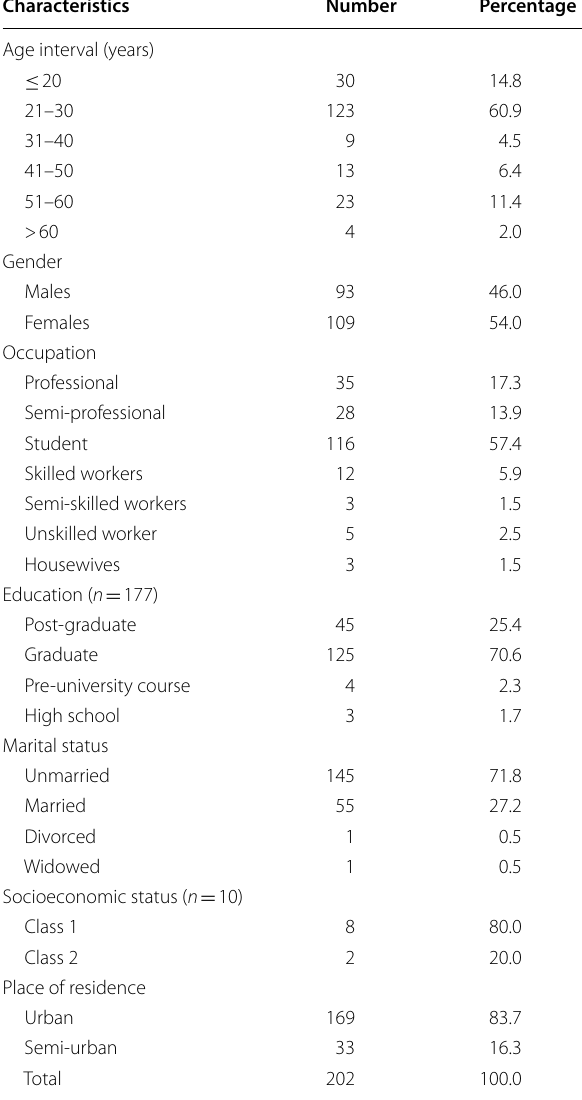
Table 1 Sociodemographic distribution of study participants